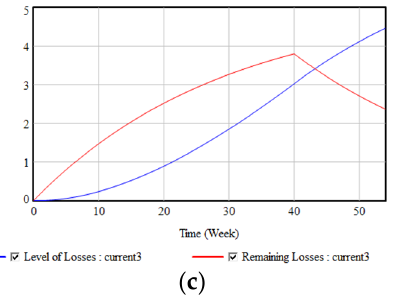
Figure 6. ( a ) Simulation results for 𝑉 (cid:2872)(cid:2869) : Work Done and Work to Do . ( b ) Simulation results for 𝑉 (cid:2872)(cid:2869) : Level of Rework and Remaining Rework . ( c ) Simulation results for 𝑉 (cid:2872)(cid:2869) : Level of Losses and Remaining Losses .